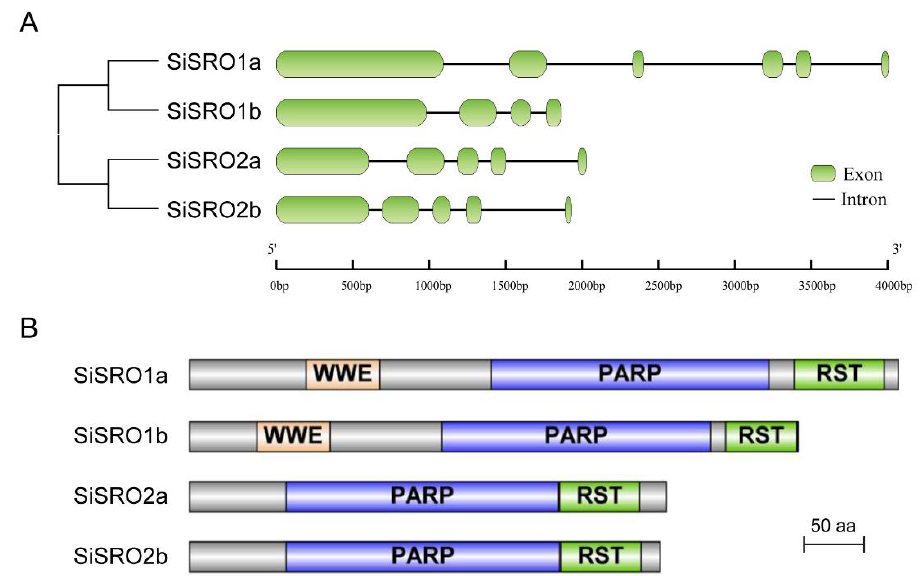
Figure 2. The exon-intron structure and conserved domain organization of SRO family in sesame. ( A ) Exon-intron structures of SiSRO genes. Exons and introns are shown as green rounded rectangles and black lines, respectively. ( B ) Schematic representation of conserved domains of SiSROs.